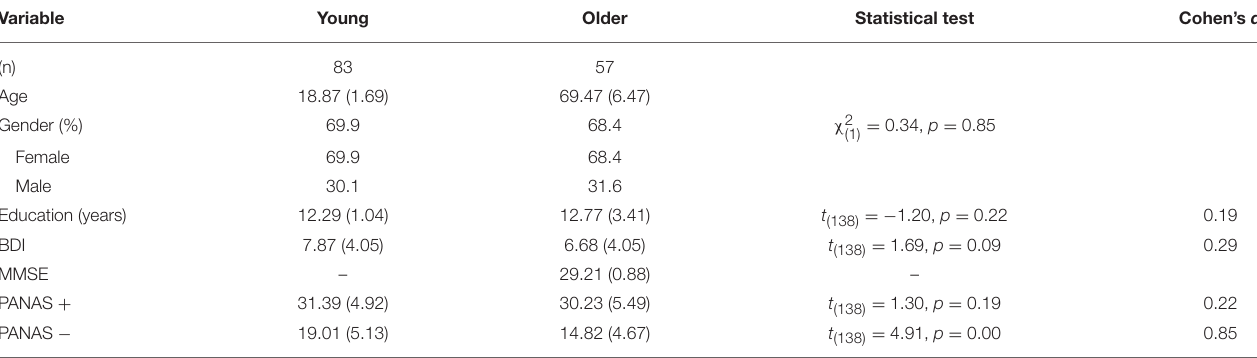
TABLE 2 | Basic socio-demographic data and participants’ scores on prior affect state.